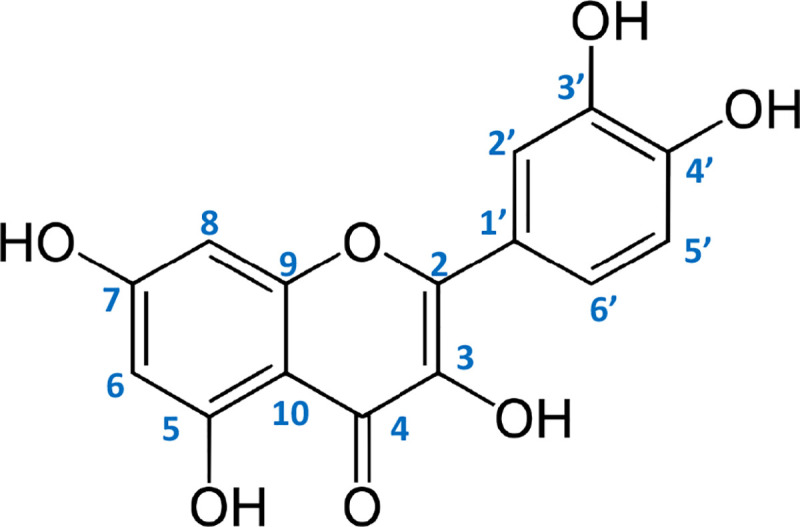
Atom numbering in flavone molecule.